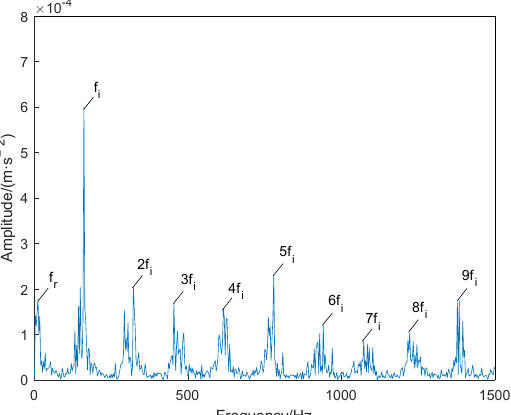
Figure 20. Envelope spectrum after direct SSA–MCKD processing.